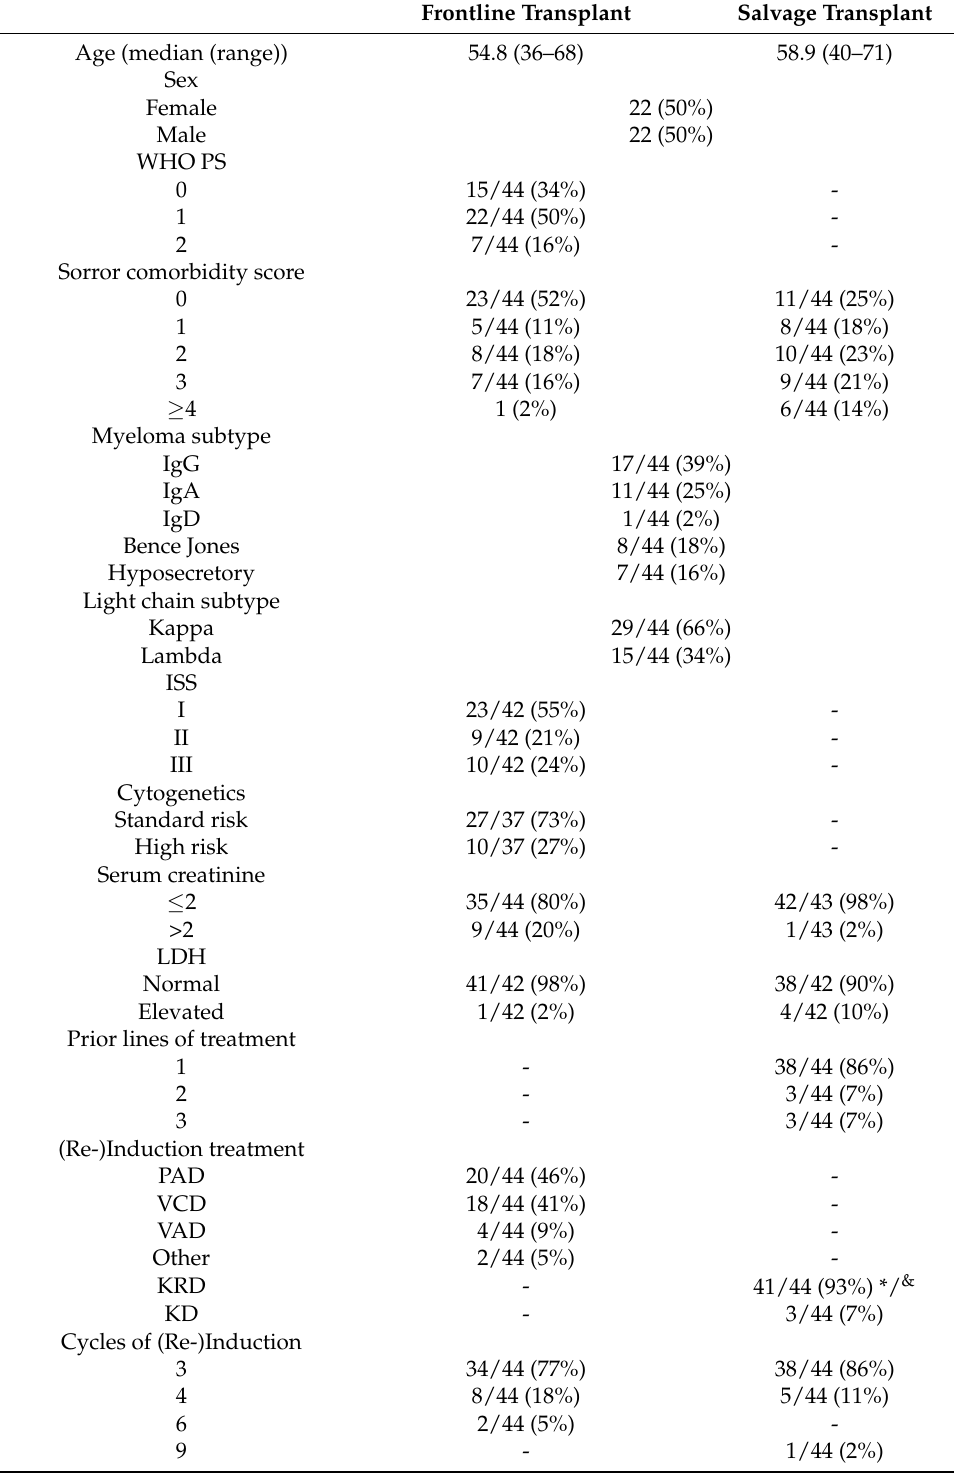
comorbidity index at the time of relapse compared to the frontline situation ( p = 0.002) due to occurrence of heart disease ( n = 12), liver disease ( n = 4), pulmonary disease ( n = 4), psychiatric disease ( n = 4), and second primary malignancy ( n = 1) in the meantime. Table 1. Patient characteristics data are n / n tested (%) or median